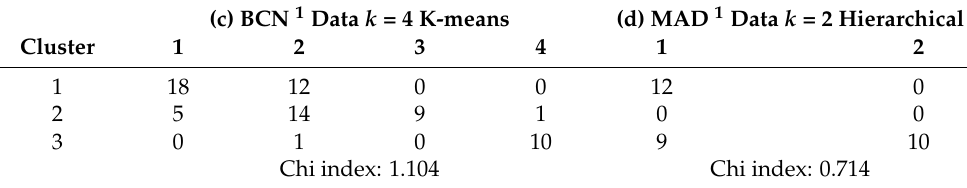
Table 8. Cont. (c) BCN 1 Data k = 4